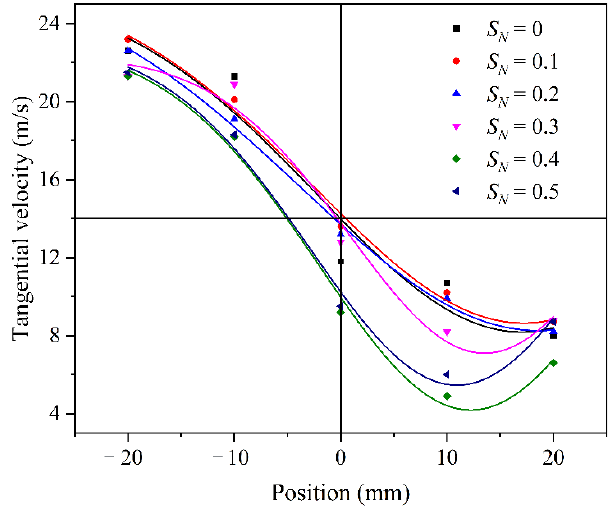
Figure 7. Tangential airflow distribution under different swirl numbers.